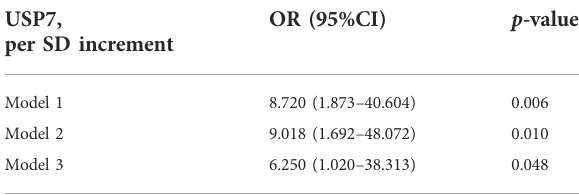
TABLE 3 Logistic regression analysis of USP7 associated with